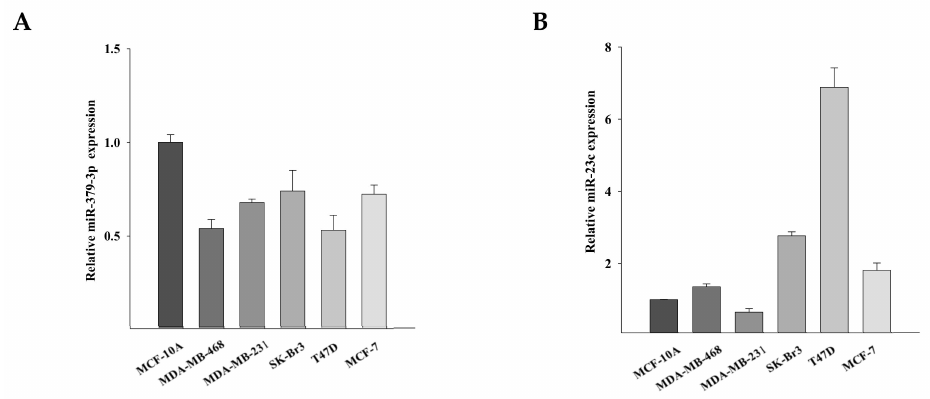
Figure 3. Levels of expression of miR-379-3p and miR-23c in breast cancer subtypes. ( A , B ) Real- time PCR analysis of miR-379-3p ( A ) and miR-23c ( B ) expression in luminal (MCF-7 and T47D), HER2 positive (SKBr3), basal (MDA-MB-468) and claudin-low (MDA-MB-231) breast cancer cell lines compared with the human breast epithelial cell line